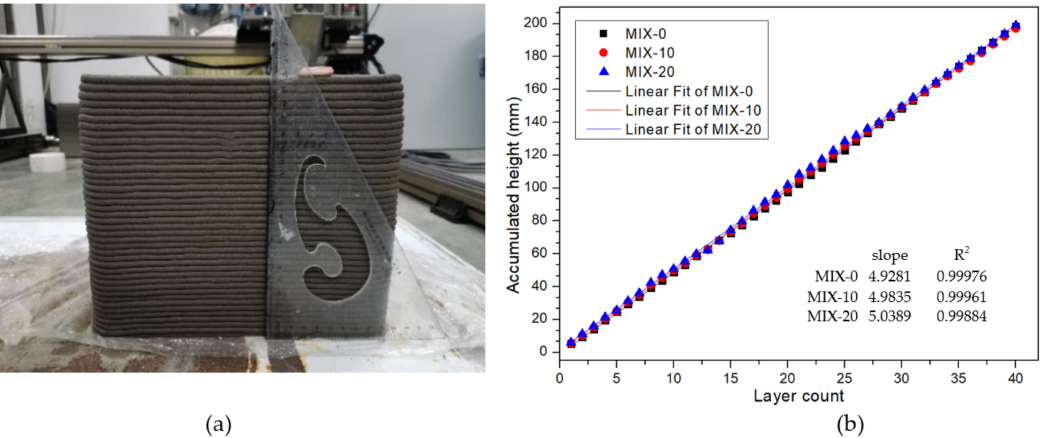
Figure 9. Buildability tests: ( a ) printed frame for layer accumulating test of MIX-0 and ( b ) the graphed data of the accumulated layer height of